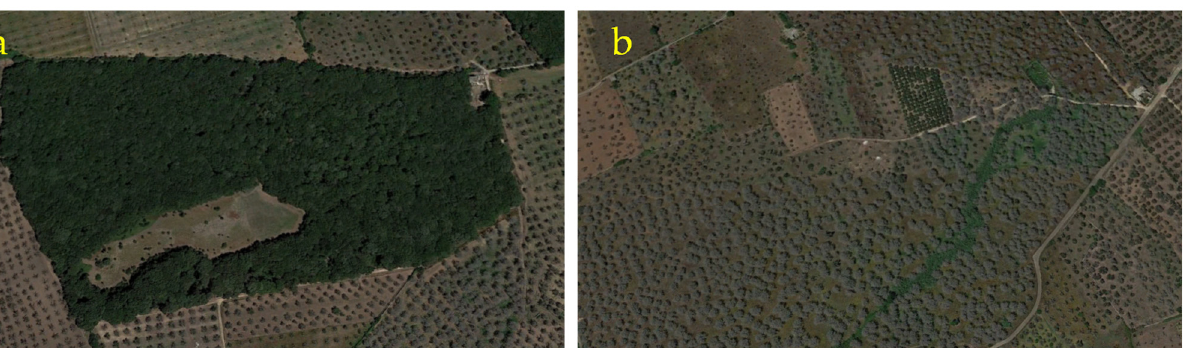
Figure 10. Representation of the same olive groves at a different time ( a ) the image refers to March, and it is possible to highlight the presence of grasslands like background vegetation; ( b ) the image refers to July, and it is possible to highlight the presences of bare soil like background. The Landsat analysis did not show any direct effect of X. fastidiosa on LST even though a drastic increase in olive grove LST from 2014 to 2020 was expected as a conse- quence of the death of olive trees mainly of the monumental trees. This is because the bacterium diffusion presumably started some years before the 2013 detection but achieved maximum diffusion and effect later, forcing the Apulia region to declare the study area compromised. The meteorological conditions during image acquisition had a strong effect on LSTs. In any case, this was also influenced by different factors. First, infected and dead olive trees remained in the field for a long time because cutting operations only began in recent years. Second, dying plants still developed basal suckers with leaves, which shaded the soil affecting LST values (Figure 11).